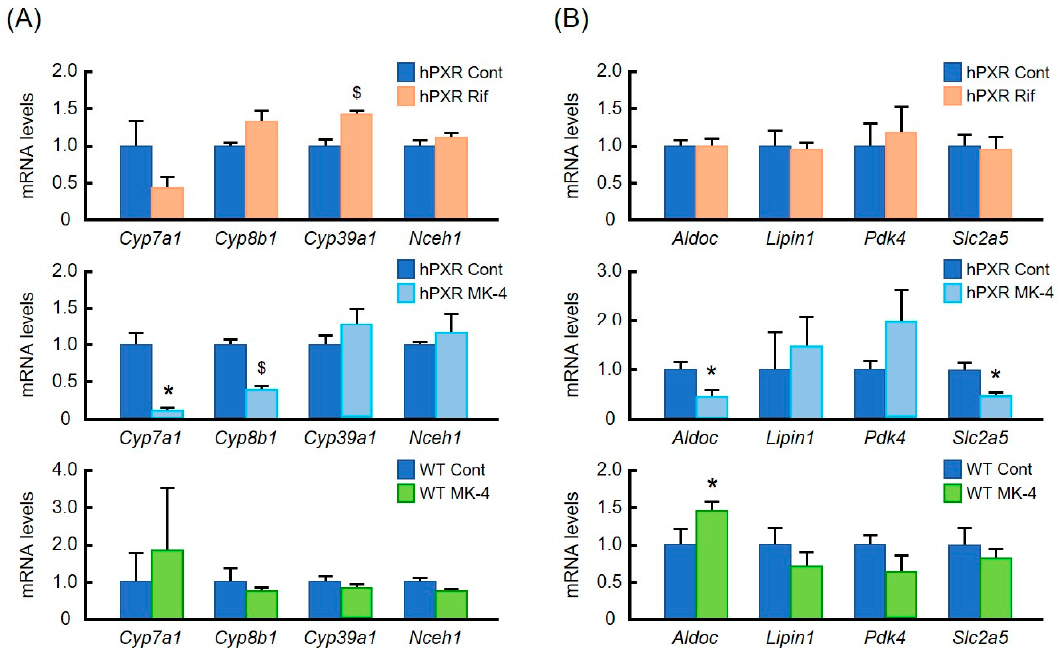
Figure 4. Effects of menaquinone-4 and rifampicin on mRNA levels of genes involved in bile acid synthesis and energy homeostasis in the liver of wild-type and hPXR mice. Menaquinone-4 (MK-4; 100 mg/kg BW) was given by oral gavage to wild-type (WT) and hPXR female mice. Rifampicin (Rif; 50 mg/kg BW) was given by oral gavage to hPXR female mice. After 6 h, mRNA levels of genes regulating bile acid synthesis ( A ) and energy homeostasis ( B ) were measured by quantitative RT-PCR. The relative mRNA levels were normalized to the amount of eukaryotic translation elongation factor 1 α 1 mRNA. Data are expressed as the mean ± SEM, n = 4–5. $ p < 0.01, * p < 0.05, compared to control groups.